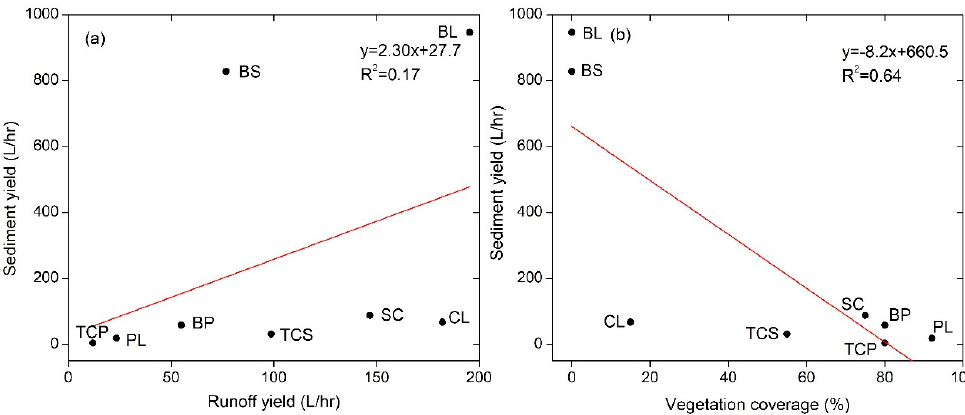
Figure 10. The relationship between sediment yield and runoff yield ( a ) and between sediment yield and vegetation coverage ( b ). The red lines denote the linear regression lines.